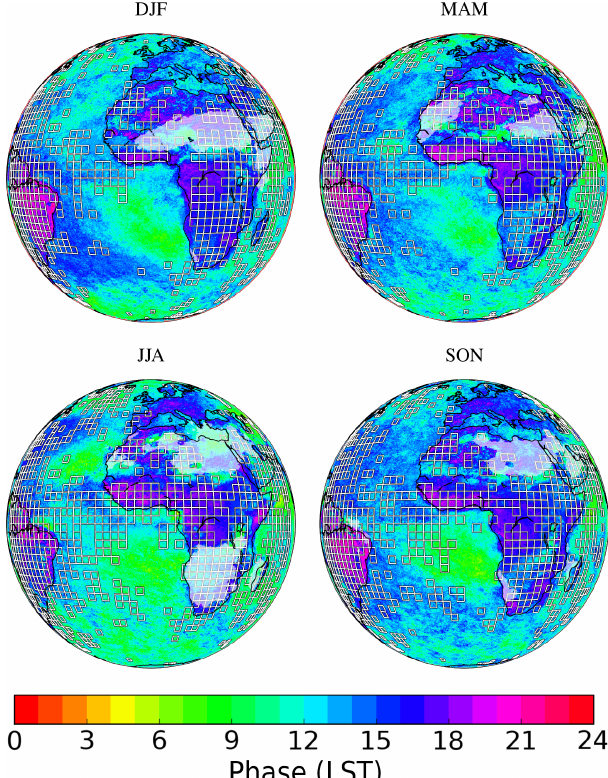
Figure 9. Seasonal mean phase (local solar time of minimum cli- matological mean CTT) of the diurnal cycle in cloud top tempera- ture for the period 2005–2015. The white overlay indicates regions where retrievals are available for fewer than 15% of the processed time steps. Squares indicate regions where the ratio of the ampli- tude of the diurnal cycle in CTT to the diurnal variability in CTT retrieval bias is less than